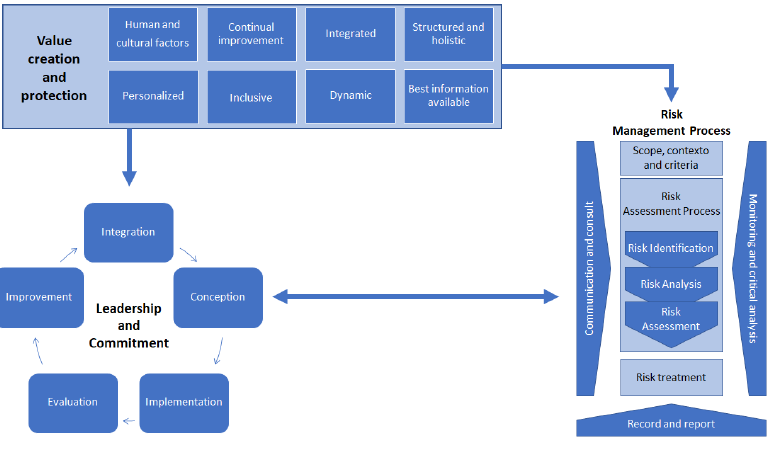
Figure 1. Elements of the Risk Management Process